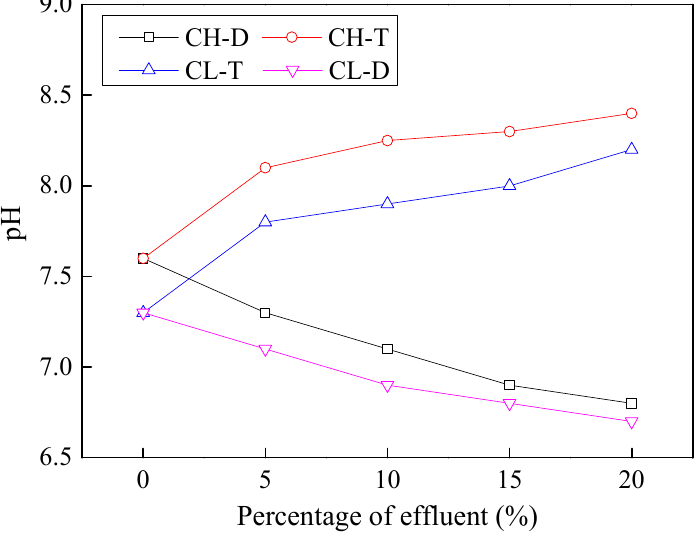
Figure 8. Effects of industrial effluents on pH of cohesive soils.